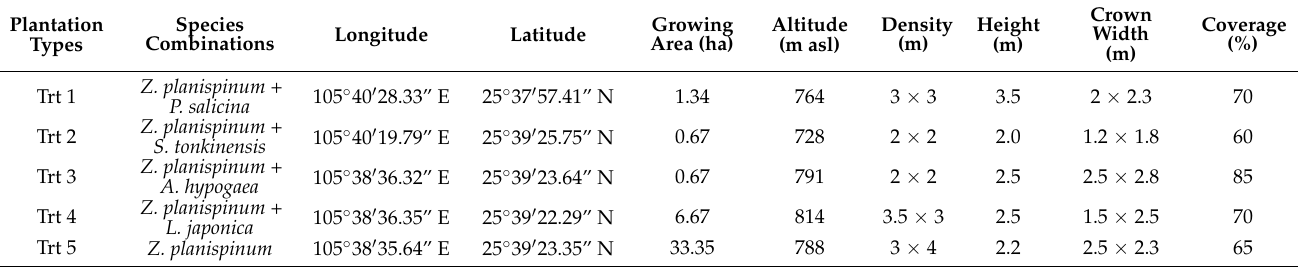
Table 1. Descriptions of the plantation types.